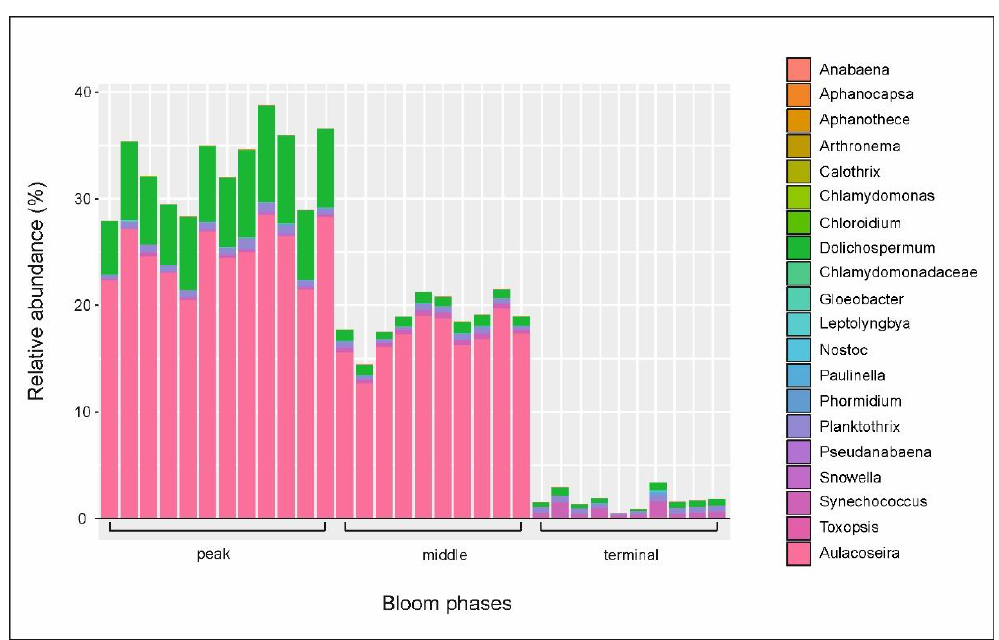
Figure 10. The relative abundance of pro- and eukaryotic photosynthetic species during various phases of HAB observed in Imandra Lake in July 2017.